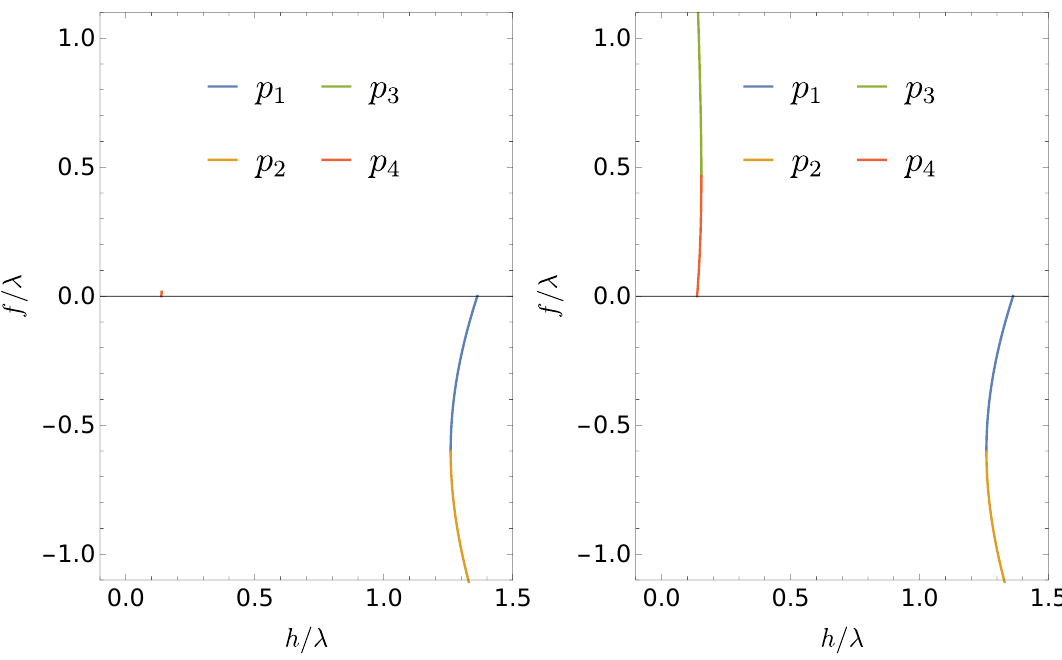
Figure 7 . Illustration of the merging of the (cid:12)xed points. On the left, we give the state of the (cid:13)ow for x s . 0 : 08. We see that the merging of the points p 1 and p 2 is already completed. On the right, for x s . 1, the points p 3 and p 4 also